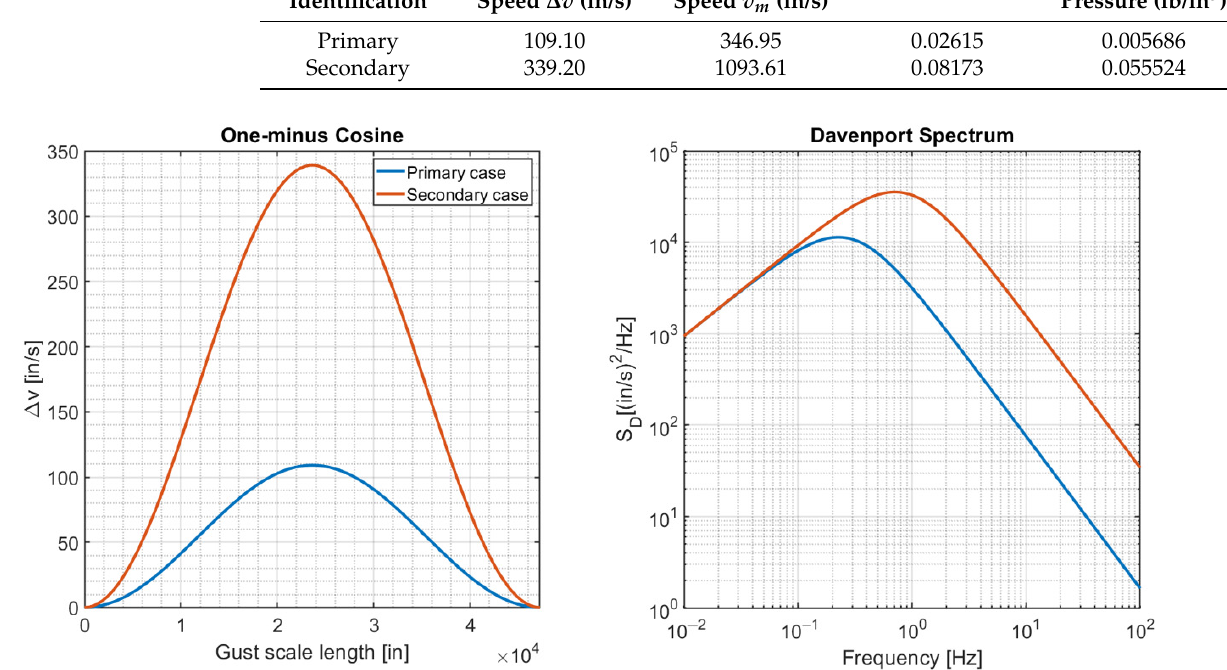
Figure 6. TDG and PSD gust models considered in the study for 14 operational conditions. The velocities indicated in the color bar are the mean wind speeds for the operational scenarios for both gust models.